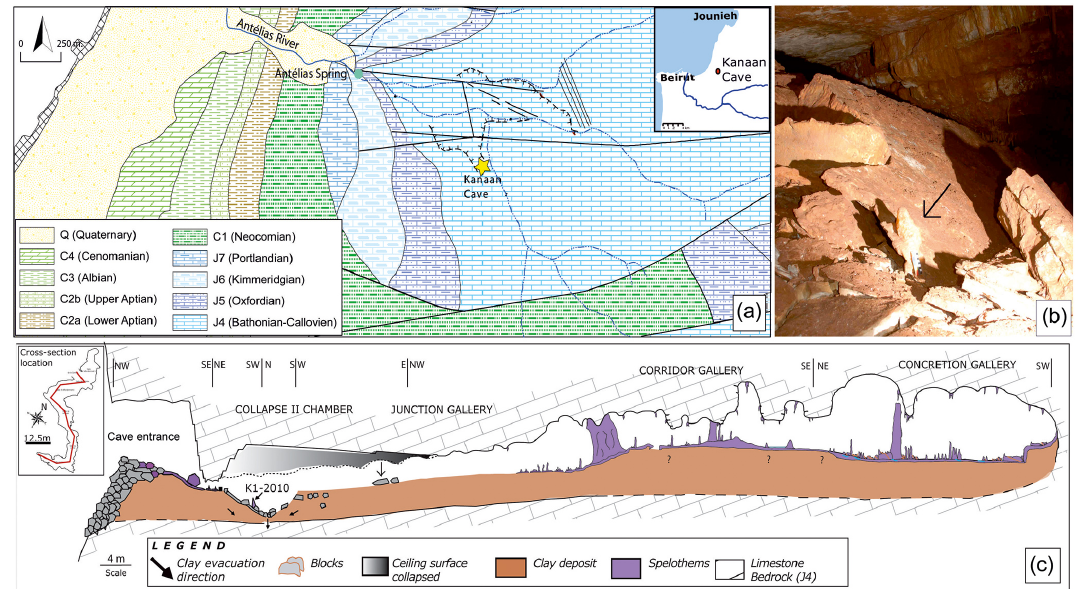
Figure 2. (a) Location map of Kanaan Cave and the continental records in the Levant. (a) Geological map of the Antelias region (western flank of central Mount Lebanon; Dubertret, 1955). (b) Photo of K1-2010 stalagmite in the Collapse Chamber. (c) Geomorphological section of Kanaan Cave showing the location of the stalagmite K1-2010 (Nehme, 2013).